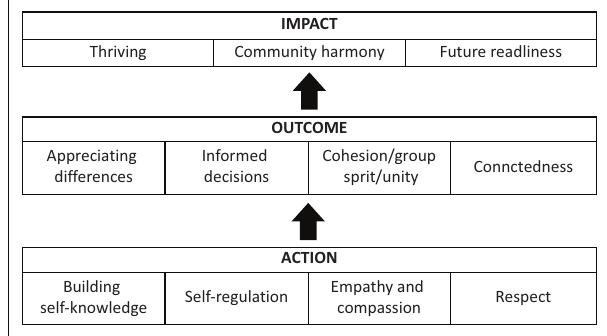
FIGURE 1: Social emotional learning skills theory of